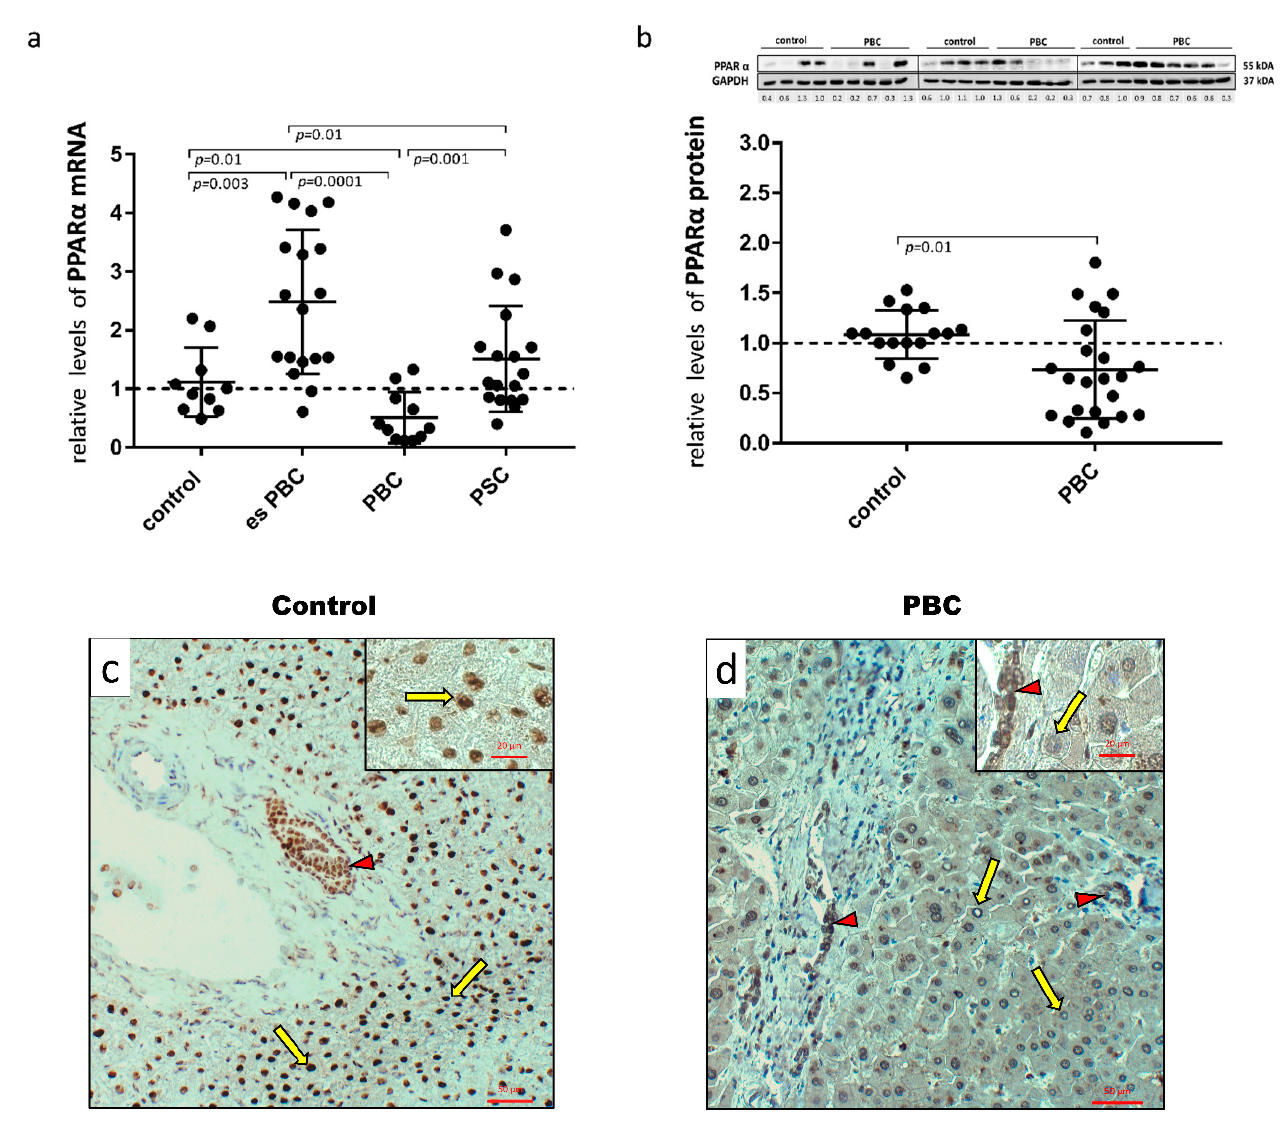
Figure 1. Presence of PPAR α in liver tissue samples obtained from the controls, the early-stages of primary biliary cholangitis (esPBC), cirrhotic PBC and primary sclerosing cholangitis (PSC) patients. PPAR α mRNA expression was suppressed in cirrhotic PBC ( a ), and Western blot analysis confirmed lower levels of PPAR α at the protein level ( b ). Levels of gene expression were normalised to the endogenous reference, 18S RNA and the levels of each protein were normalised to GAPDH. Dots illustrate each patient, and the data are presented as mean plus interquartile range (IQR). Statistical analysis was performed using ANOVA or a Student’s t -test. Immunohistochemical staining clearly showed a dominant nuclear localisation of the PPAR α protein in the control tissue ( c ) in contrast to liver tissue from patients with PBC ( d ). Both hepatocytes (yellow arrows) and cholangiocytes (red arrow heads) were positive for PPAR α . Original magnification 200× or 400× (inserts).